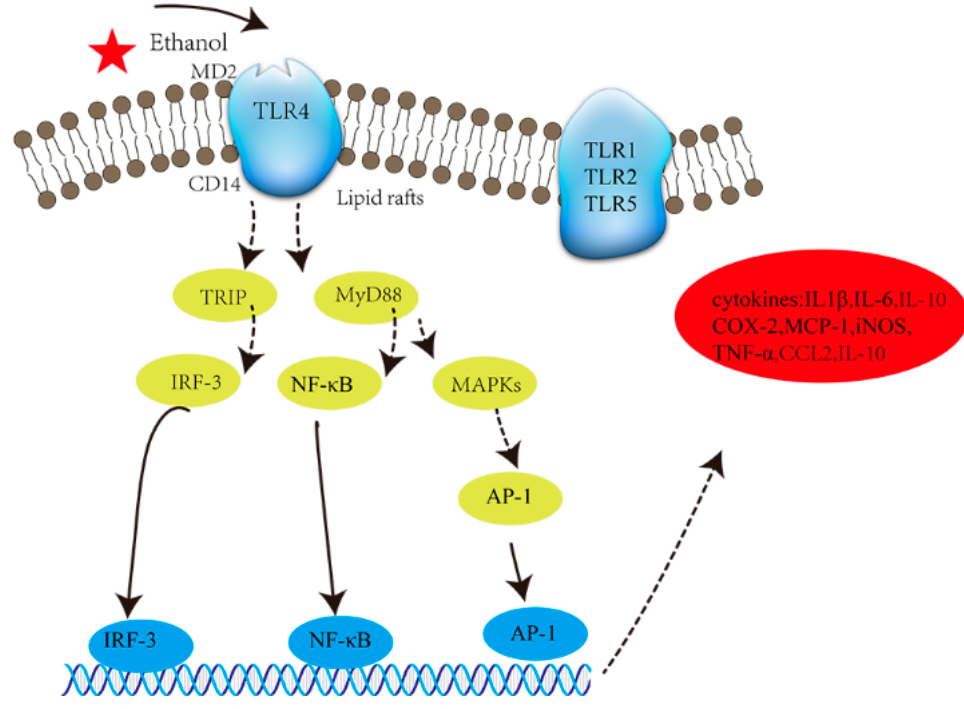
Figure 2. The activation of TLR4. Key: MD2: myeloid differential protein 2; CD14: membrane CD14; MAPK: mitogen ‐ activated protein kinase; MCP ‐ 1: monocyte chemoattractant protein ‐ 1; IL ‐ 6: inter ‐ leukin ‐ 6; TNF ‐α : tumor necrosis factor ‐α ; IL1 β : interleukin ‐ 1 β ; CCL2: chemokine ligand 2.